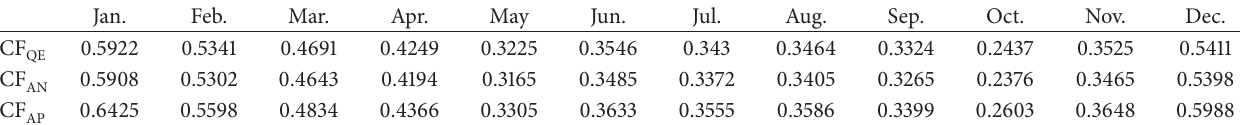
Table 5: Comparison of 2008 monthly capacity